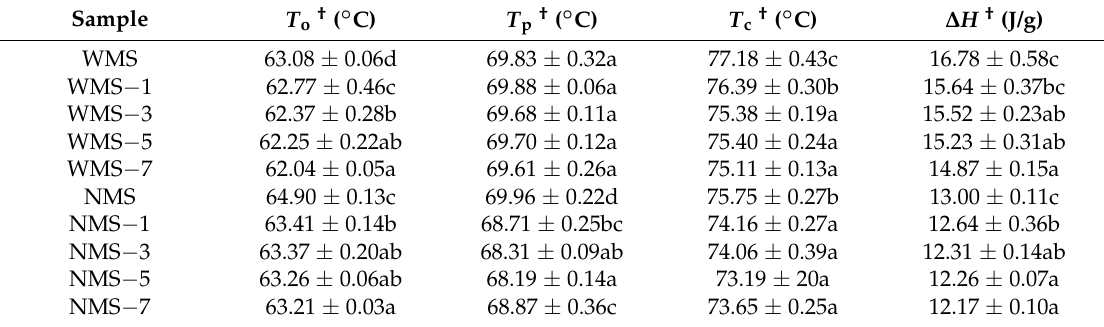
Figure 7. Gelatinization properties of maize starch samples treated by APPJ. ( a ) Waxy maize starch ( b ), normal maize starch. Table 2. Thermal properties of untreated and APPJ-treated